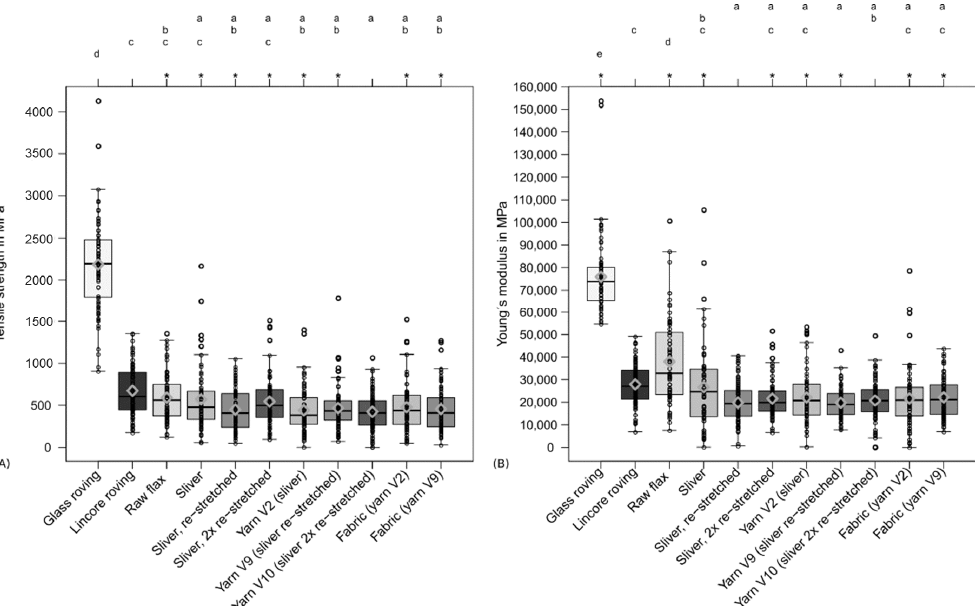
Figure 6. Properties of raw flax and single fibre bundles prepared from slivers, yarns and fabrics. ( A ) Tensile strength and ( B ) Young’s modulus shown as box-whisker plots with rhombuses as mean values. Different letters indicate significant differences between the results. Results that are not normally distributed are marked with *.